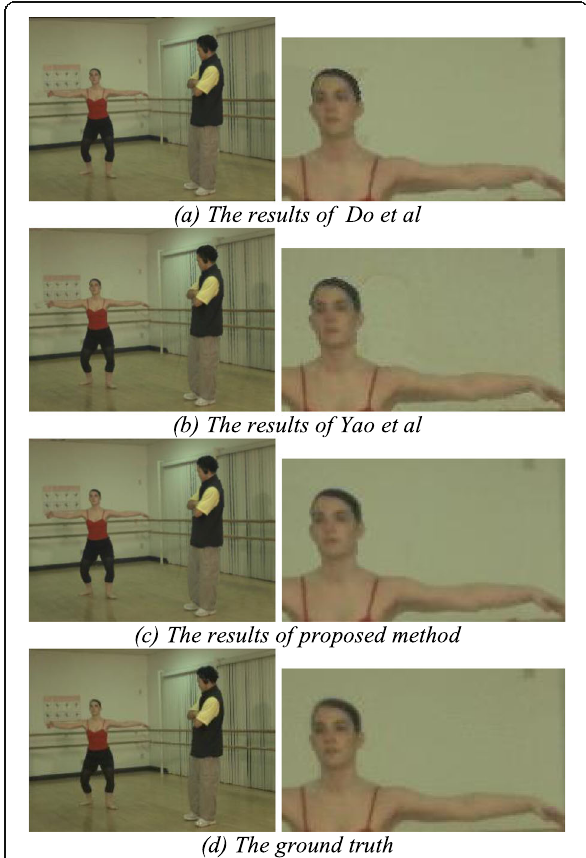
Fig. 8 The results for “ Ballet ” sequence. a The results of Do et al. b The results of Yao et al. c The results of proposed method. d The ground truth. From the enlarged detail image,we can see that ( a ) contains some errors around the arm of the ballet dancer; ( b ) contains some artifacts on the wall; ( c ) contains nearly no error or artifacts